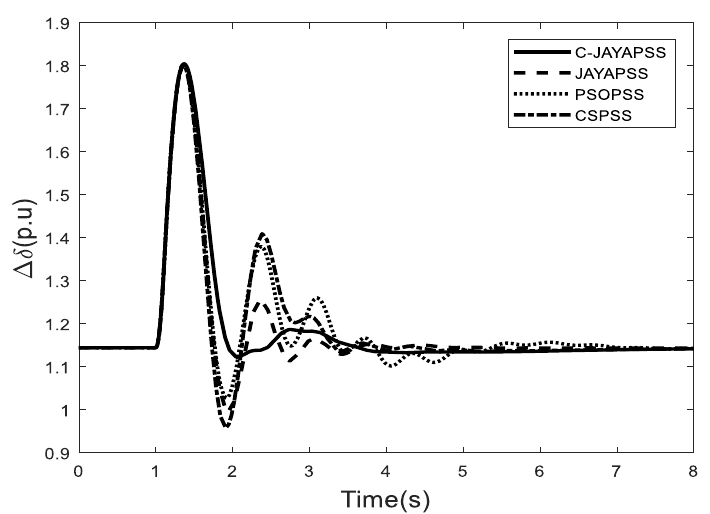
Figure 11. Rotor angle response for a six-cycle fault disturbance with case 2.